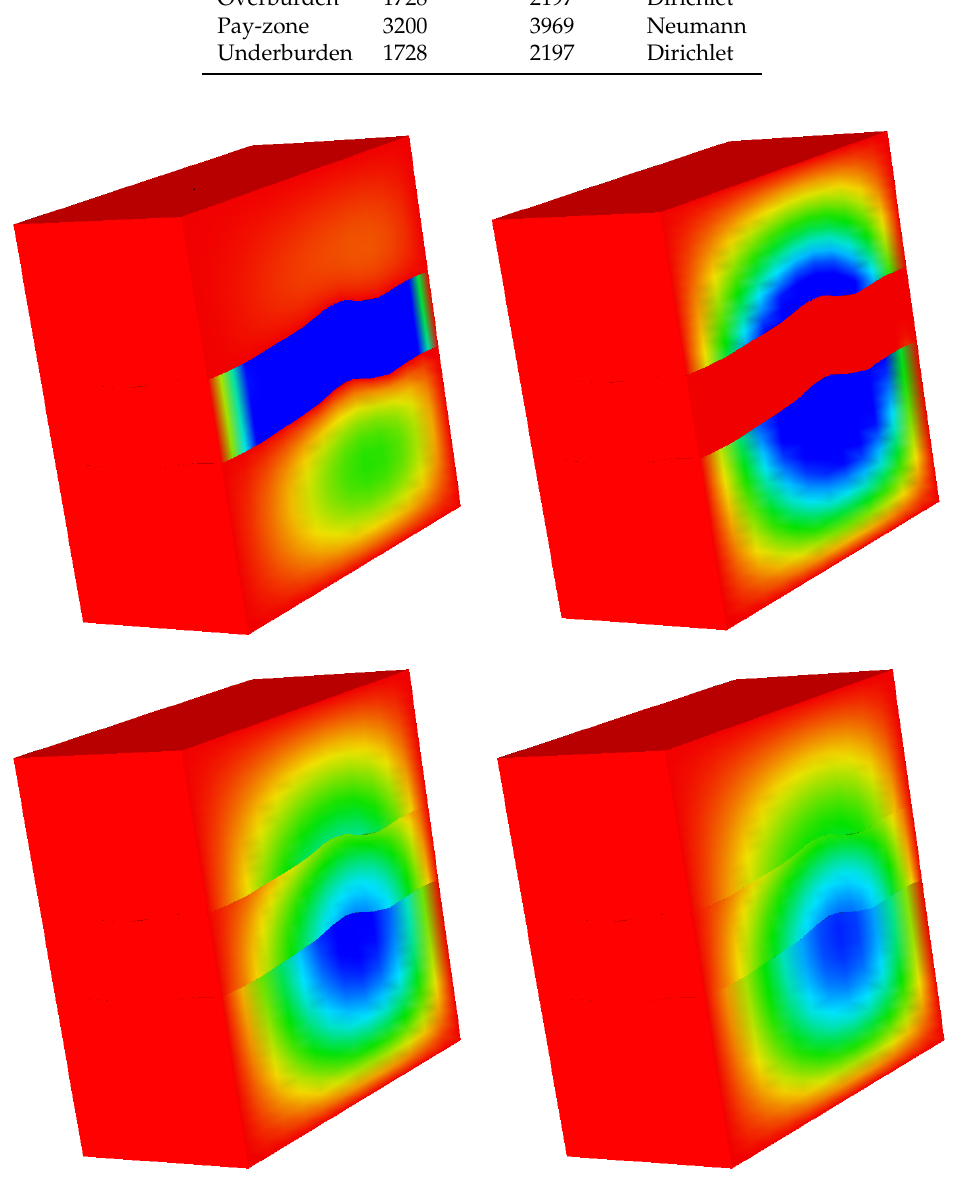
Figure 10. Pressure variation during DN steps. Figure 11 pictures the final parallel answer, which agrees well with the above-assumed pressure. The L 2 -error for the Dirichlet subdomain is about 3.60 10 − 1 , and for the Neumann improves to × 4.05 10 − 2 . The resulting error values are small related to the magnitude of p ×